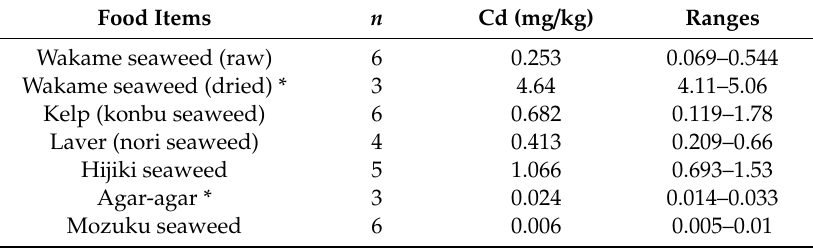
Table 6. Cadmium (Cd) concentrations in seaweed and seaweed products. Data are presented as arithmetic means.